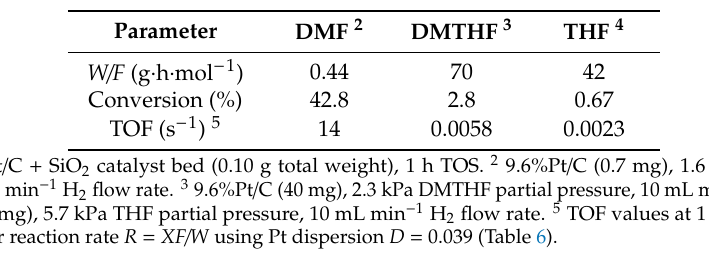
Table 5. Total TOF values for Pt-catalyzed hydroconversion of furanic compounds 1